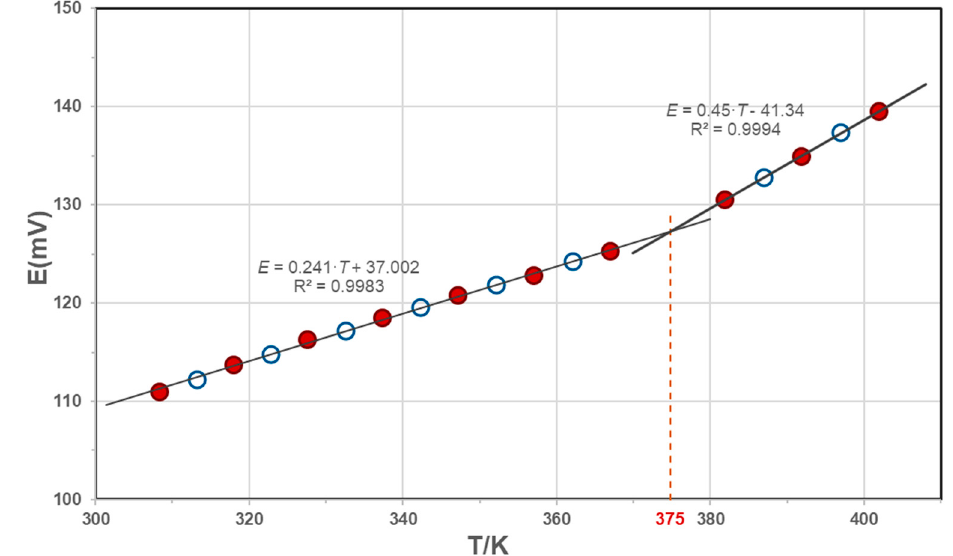
Figure 8. A summary of the E vs. T relations measured with the electrochemical cell (cell I), the least square fittings of the experimental points are shown with the solid lines. Notations: • —the measurement points attained in the heating cycles, and cooling